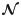
Global time to visit N locations.The value τ(α)(R) gives the average number of steps needed to reach any of the N sites, independently of the initial condition; we use N=100 random sites in the region [0, 1] × [0, 1] in R2. The results are obtained from the analytical expressions in Eqs (5) and (6), in the Methods section, and the eigenvectors and eigenvalues of the transition matrix with elements wa→b(α)(R).